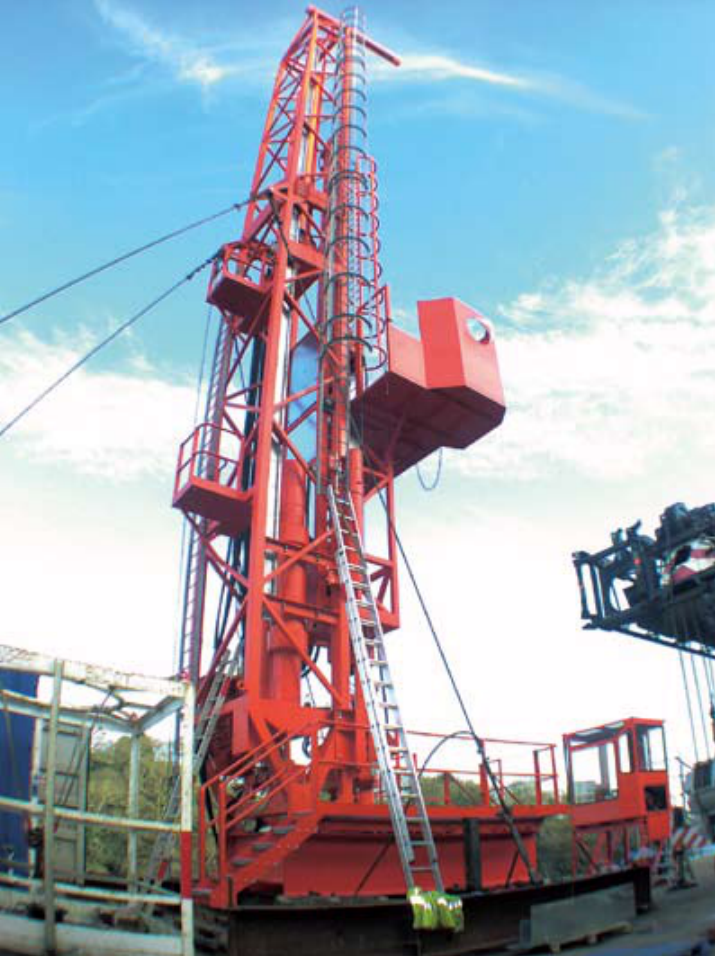
Figure 2. The R-50 rig assembled in the Seacore yard in